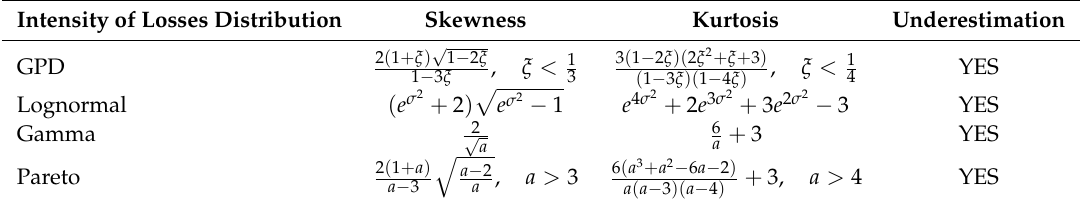
Table 4. Moments of common distributions and underestimation presence (the conditions on parameters ξ and a assure that skewness and kurtosis are not